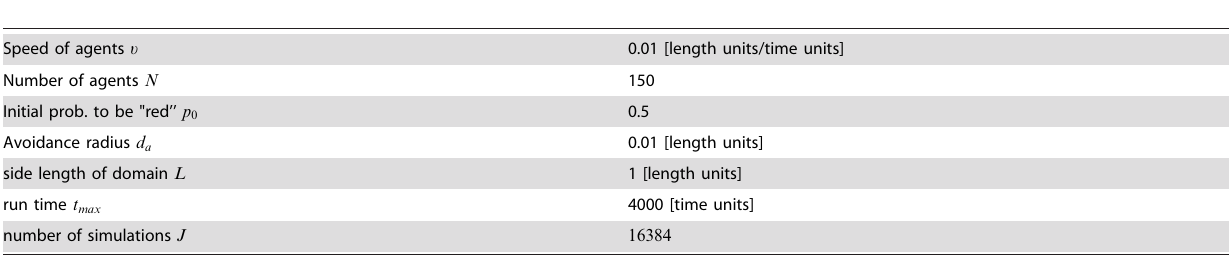
Table 3. Parameters for the macroscopic-discrete simulations of the virtual swarm using inchman.